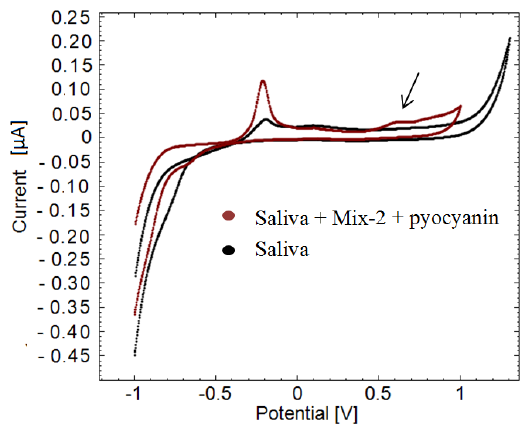
Figure 7. Example of pyocyanin detection in human saliva sample. Black illustrates a cyclic voltammogram of human saliva without pyocyanin. Dark red cyclic voltammogram is of human saliva containing pyocyanin and mix. The peak around 0.60 V versus the reference electrode confirms the presence of pyocyanin in the sample (arrow).